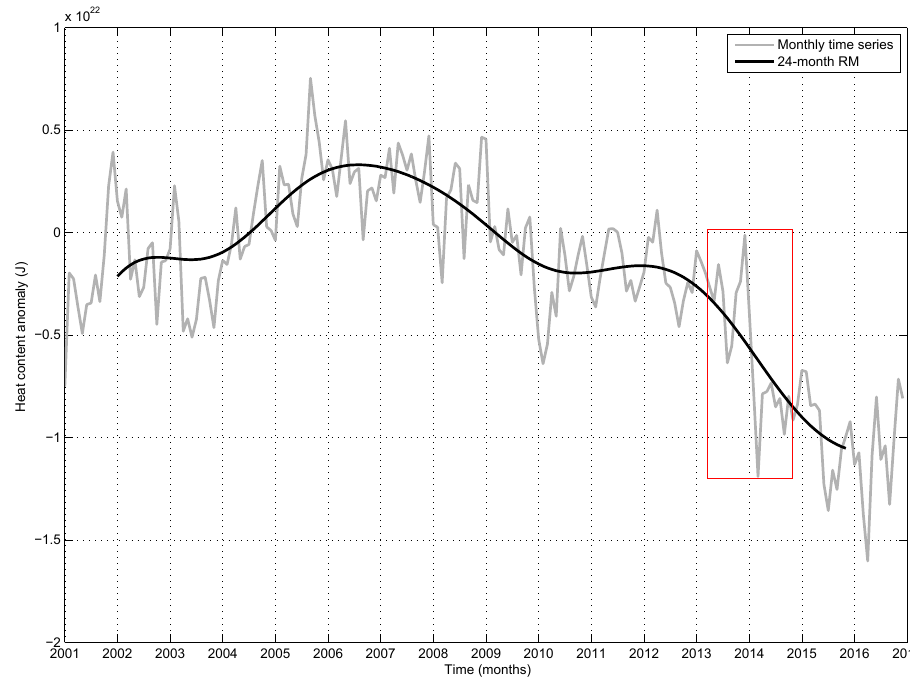
Figure 9. Heat content anomalies with respect to the mean heat content for the period 2002–2012 in the upper 1000m of the region 40–60 ◦ N, 45–10 ◦ W: the monthly time series in gray and the 2-year running mean in black. Data source: EN4 database (Good et al., 2013). The red square highlights the short-term cooling event analyzed in this paper.